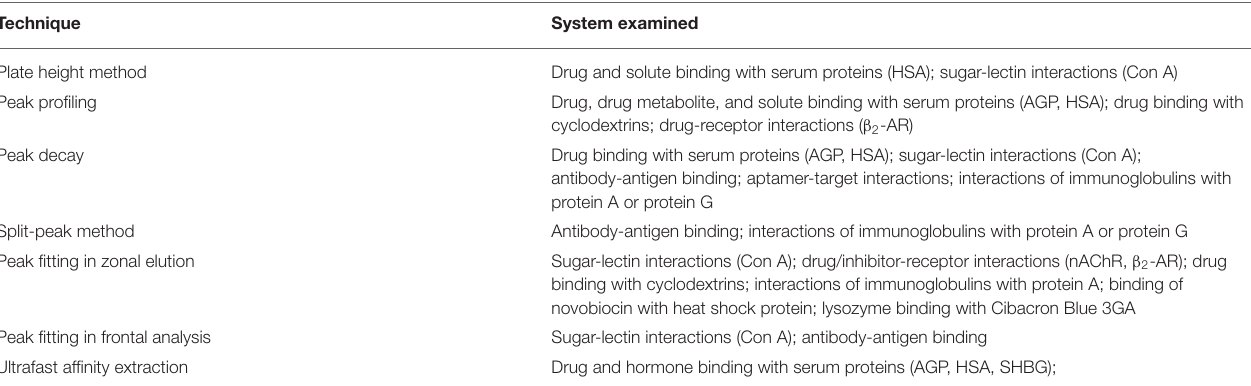
TABLE 2 | Applications of affinity chromatography and HPAC in kinetic studies a .